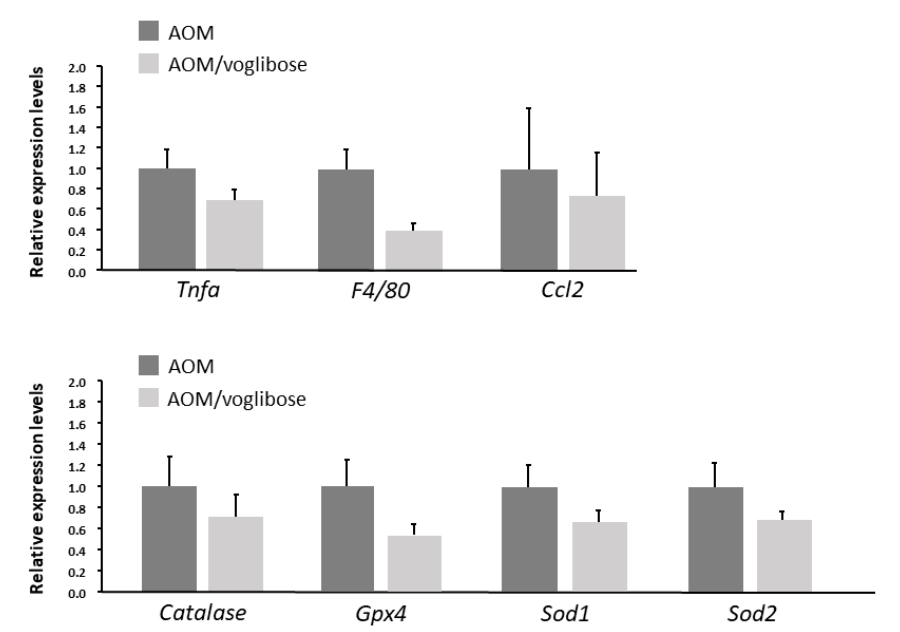
Figure 2. mRNA expression levels of inflammatory cytokines and anti-oxidative enzymes in colonic mucosa of experimental mice. Relative expression levels of mRNA of Tnf-a, F4/80, Ccl-2, catalase, Gpx-4, Sod-1, and Sod-2 measured by qRT-PCR. 18S was used as the internal control. Data represent means ± S.E. from the various experimental groups. AOM, azoxymethane.